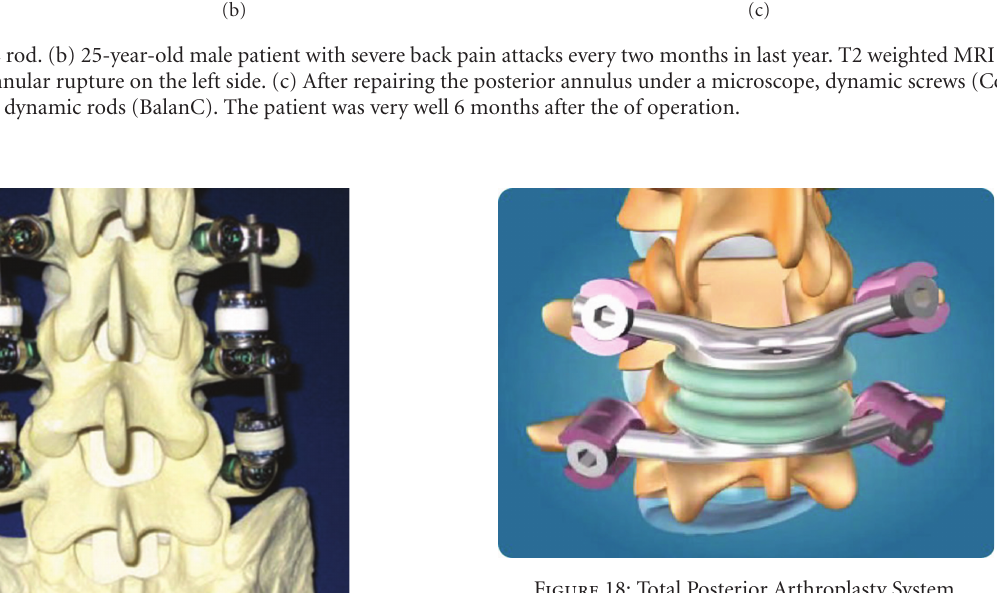
Figure 18: Total Posterior Arthroplasty System.